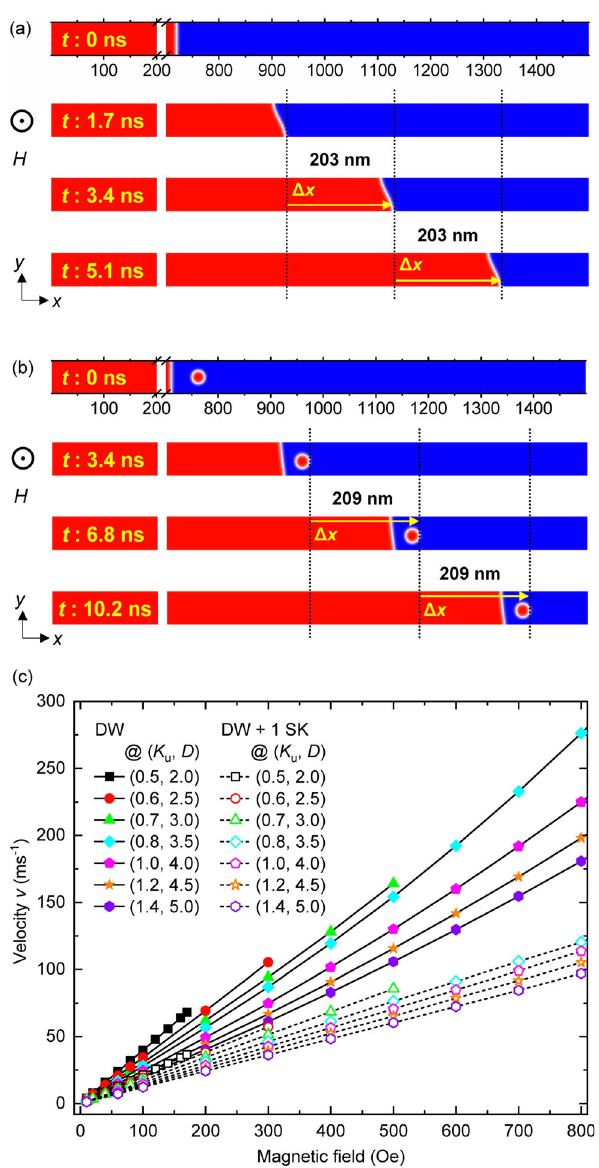
Fig. 2 Field-driven dynamics of a single domain wall and a domain wall – skyrmion pair. a Domain wall (DW) motion and ( b ) DW – skyrmion pair motion in a positive fi eld ( fi eld strength H = 400 Oe) through expansion of the up domain. The time after applying the fi eld is indicated on each panel. Through a similar distance ( Δ x : 209 vs 203 nm), the DW – skyrmion pair spends twice as much time as the single DW ( Δ t : 3.4 vs 1.7 ns), meaning that the DW speed roughly halves when a skyrmion is carried. c Velocities of a single DW and a DW – skyrmion pair against fi eld strength for various ( K u , D ) as indicated, where K u and D are the strengths of perpendicular magnetic anisotropy and Dzyaloshinskii-Moriya interaction. Lines are guides to eyes. Irrespective of the fi eld strength and ( K u , D ), the velocities of the DW – skyrmion pair are always nearly half of those of the single DW, suggesting the universality of the The DW velocity versus fi eld curves, for a series of ( K u , D ) combinations, are plotted in Fig. 2c, from which several signatures can be identi fi ed. We would like to note that, for clarity, the cut-off fi elds on the velocity – fi eld curves in Fig. 2c are set to the skyrmion annihilation fi elds, although, for all ( K u , D ), the DW breakdown fi elds are concertedly far larger than the skyrmion annihilation fi elds, as listed in Supplementary Table S1.